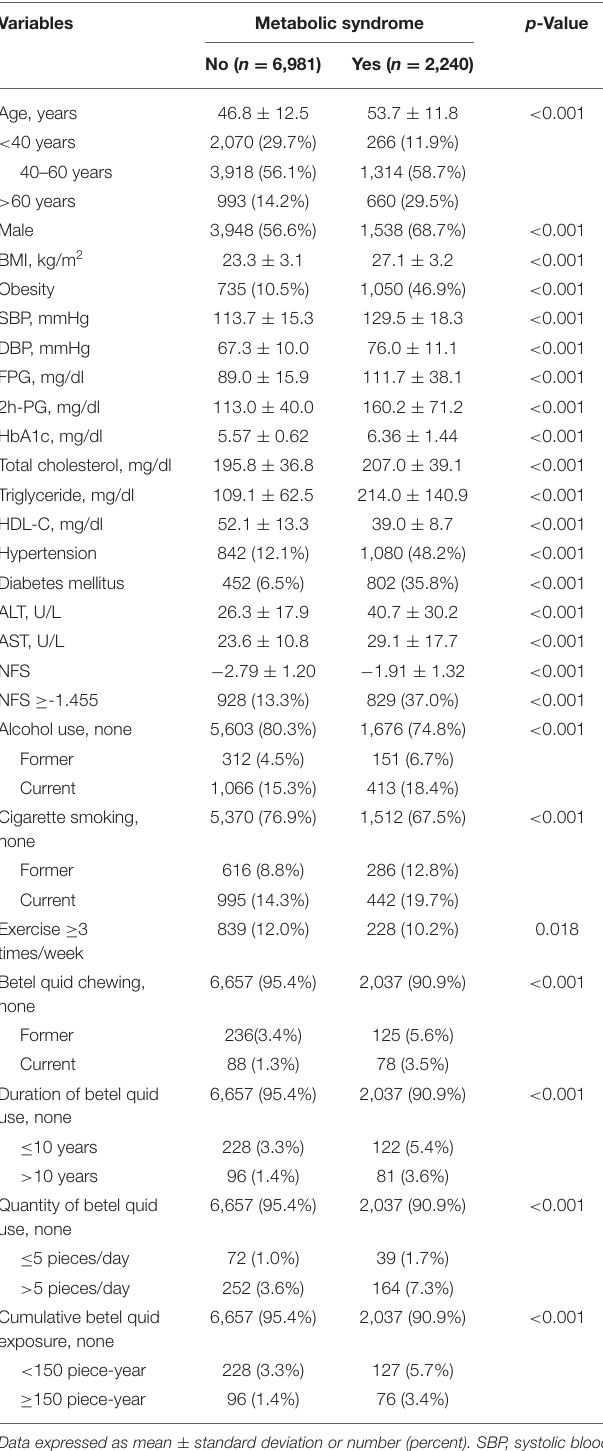
TABLE 1 | Comparisons of participants’ clinical characteristics among subjects with or without metabolic